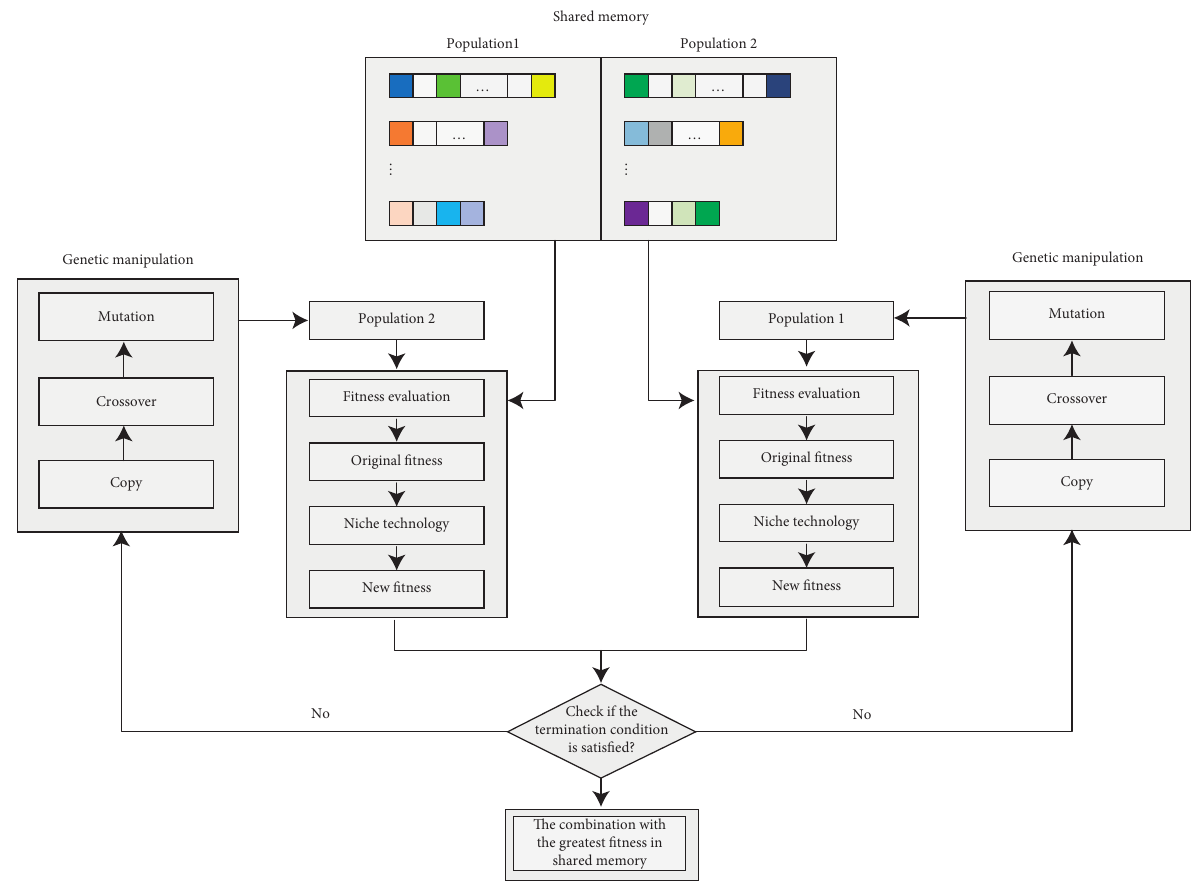
Figure 4: Flowchart of coevolutionary